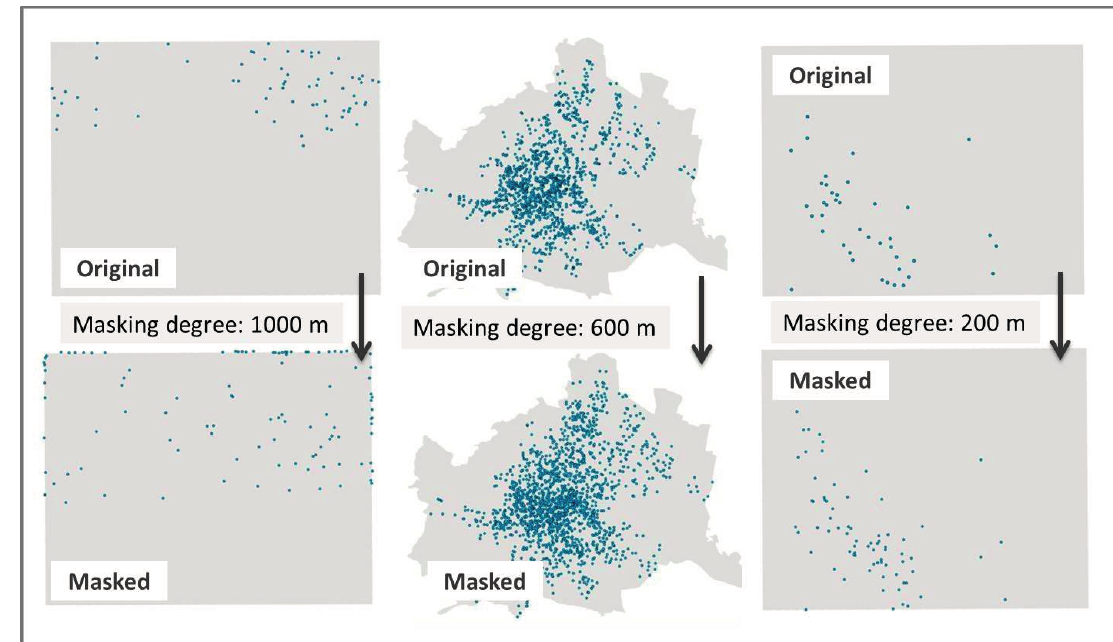
Figure 2. Three pairs of original versus masked maps of different masking degrees.